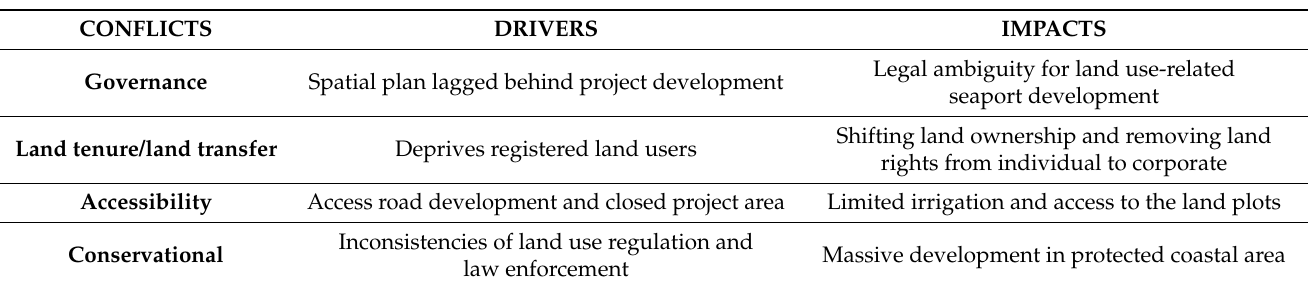
Table 4. Conflicts, Drivers and